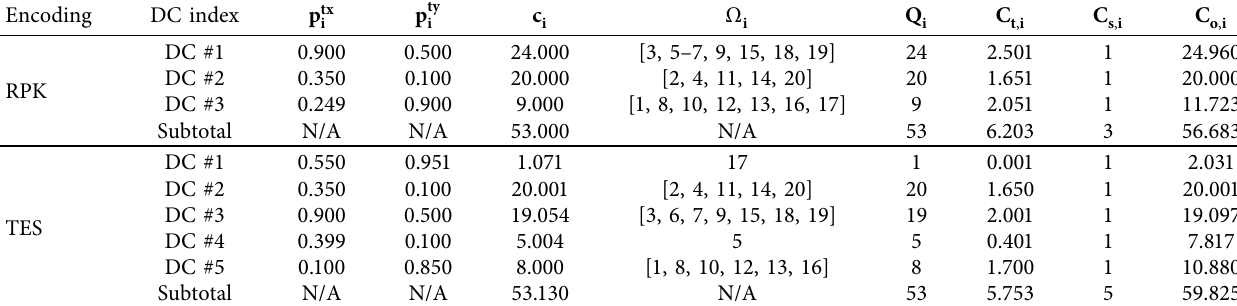
Table 4: The detailed location and allocation plan of ABC using RPK and TES encoding schemes.